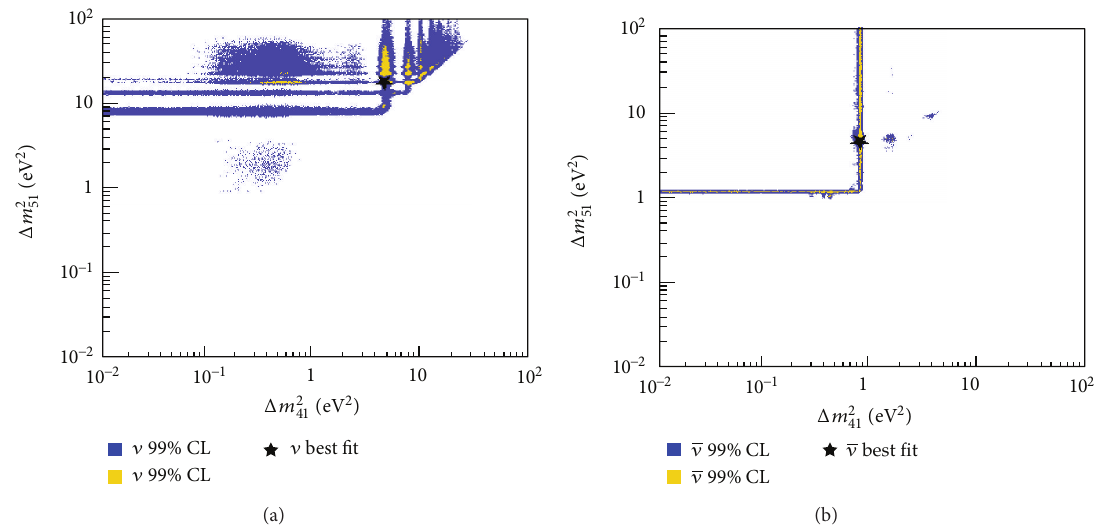
Figure 8: The Δ𝑚 2 51 versus Δ𝑚 2 41 allowed space from fits to neutrino (a) and antineutrino (b) data in a ( 3 + 2 ) model.